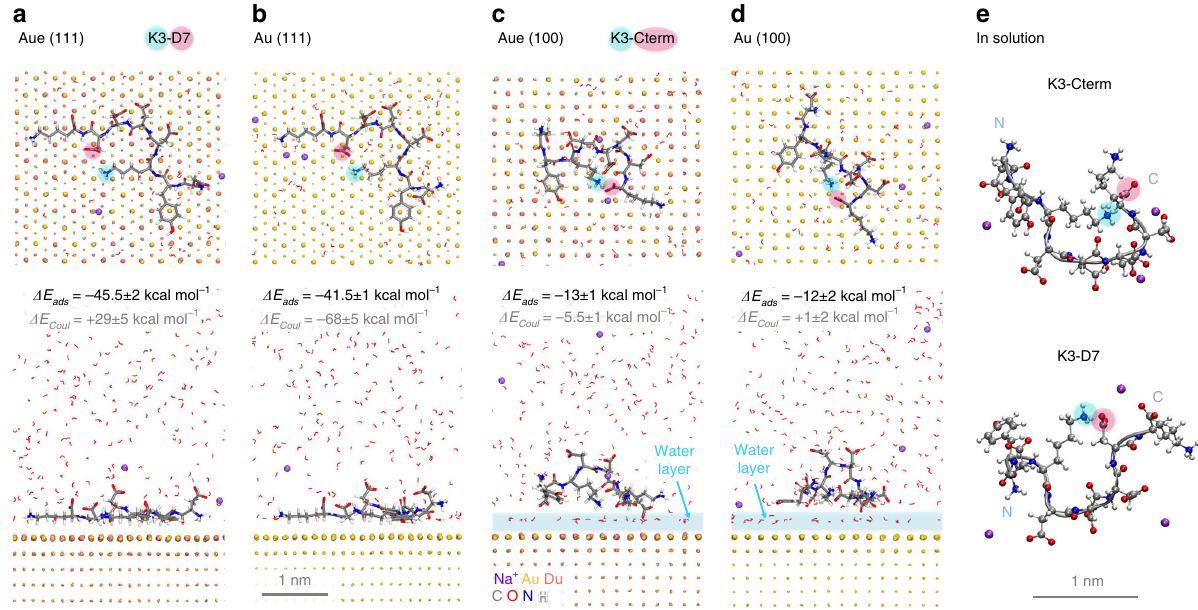
Fig. 6 Representative conformations and adsorption energies of an ionic peptide on gold surfaces. The interaction of the peptide DYKDDDDK (FLAG-Tag) with gold (111) and (100) surfaces was analyzed in aqueous solution at 298 K and pH 7 (FLAG-Na3) using the polarizable model (Aue) and the nonpolarizable model (Au). a , b . On the (111) surface, the peptide assumes a fl at-on conformation in direct contact with the surface using both models. The preferred peptide conformation is very similar and involves a K3-D7 salt bridge (highlighted). Adsorption is driven by soft epitaxy, i.e., proximity of polarizable atoms (C, O, N) to hollow sites in the 2nd and 3rd subsurface layer, and avoidance of atoms in the top layer. Overall adsorption is somewhat stronger using the polarizable model and the contribution of Coulomb energy to adsorption is of opposite sign (see text). c , d On the (100) surface, the peptide maintains a distance of one water layer from the Au surface atoms (see highlight) and retains conformational fl exibility similar to that in solution. The preferred adsorbed conformation involves an ion pair between K3 and the C terminus. Adsorption energies are about the same for polarizable and non- polarizable models and much weaker in comparison to the (111) surface. Coulomb contributions to the adsorption energy differ signi fi cantly between the two models. e Preferred conformations of the FLAG-tag peptide in solution. The K3-Cterm salt bridge corresponds to lowest energy, while also K3-D7 bridges, Nterm-D7, D4-K8, Nterm-D6, Nterm-D5, and D6-K8 bridges were temporarily observed. Water molecules are partially shown in panels ( a – d ). The three sodium ions per peptide often move several nanometers away from the peptide and are shown only partly in panels ( a ) and ( b